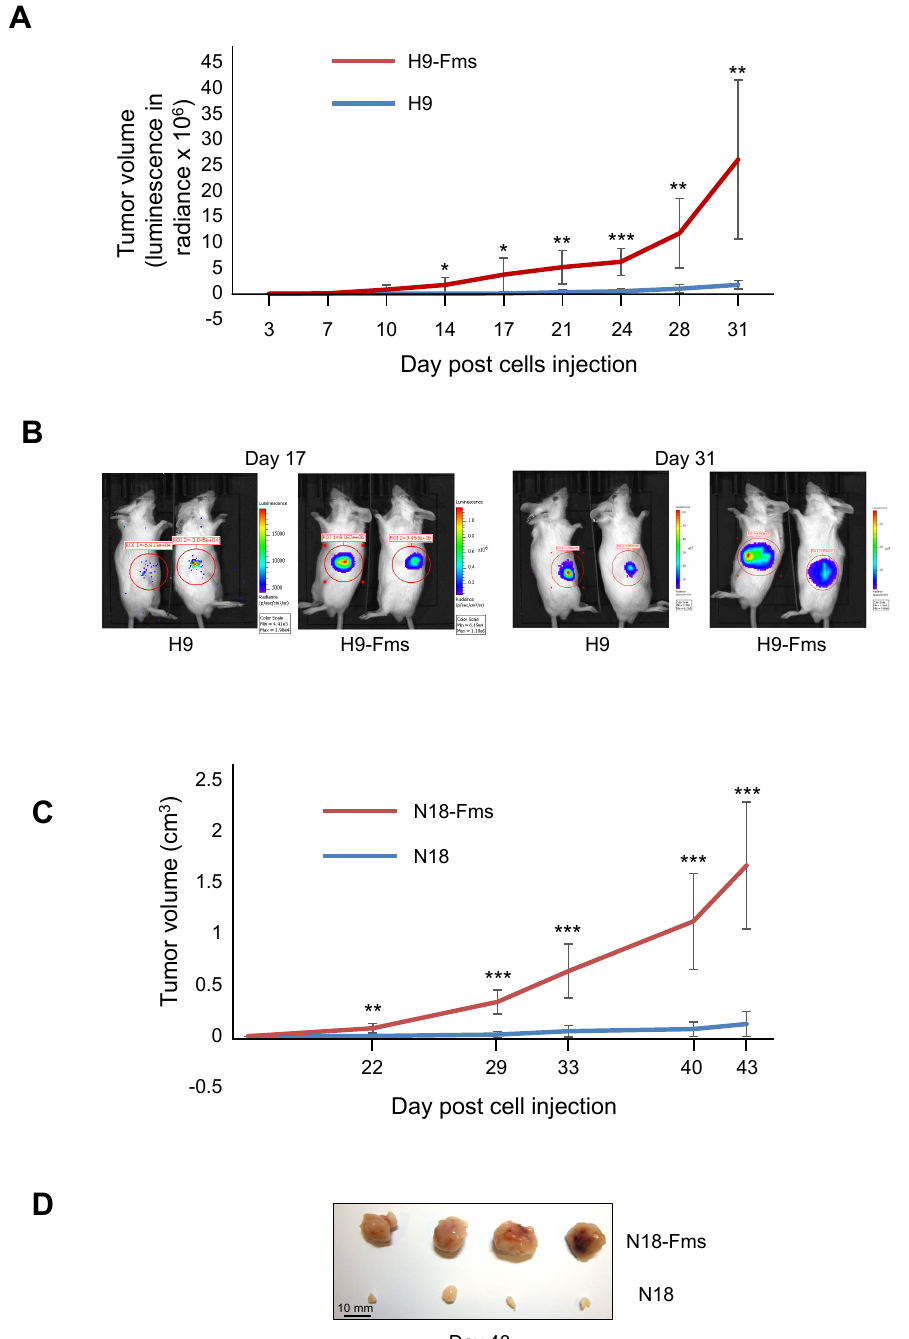
Figure 3. Tumor volume evolution of xenografted prostate C2H subclones. ( A ) Each male SCID mice were injected subcutaneous with H9-Fms (left flank) and control H9 (right flank) cells, both cell populations stably expressing luciferase gene. Every 3 or 4 days, luminescence was measured in radiance (photon/second/cm 2 /steradians). ( B ) Photographic demonstration of comparative tumor size of 2 mice at day 17 (left panels) and day 31 (right panels). ( C ) Each male SCID mice were injected subcutaneous with N18-Fms (left flank) and control N18 (right flank) cells. Tumor volume was measured using calipers. ( D ) Forty-three days after cell injection, tumors were removed from 4 mice and photographed. For all these experiments, each group contained eight mice. The values are expressed as mean ± s.d. * p < 0.05, ** p < 0.01, *** p <